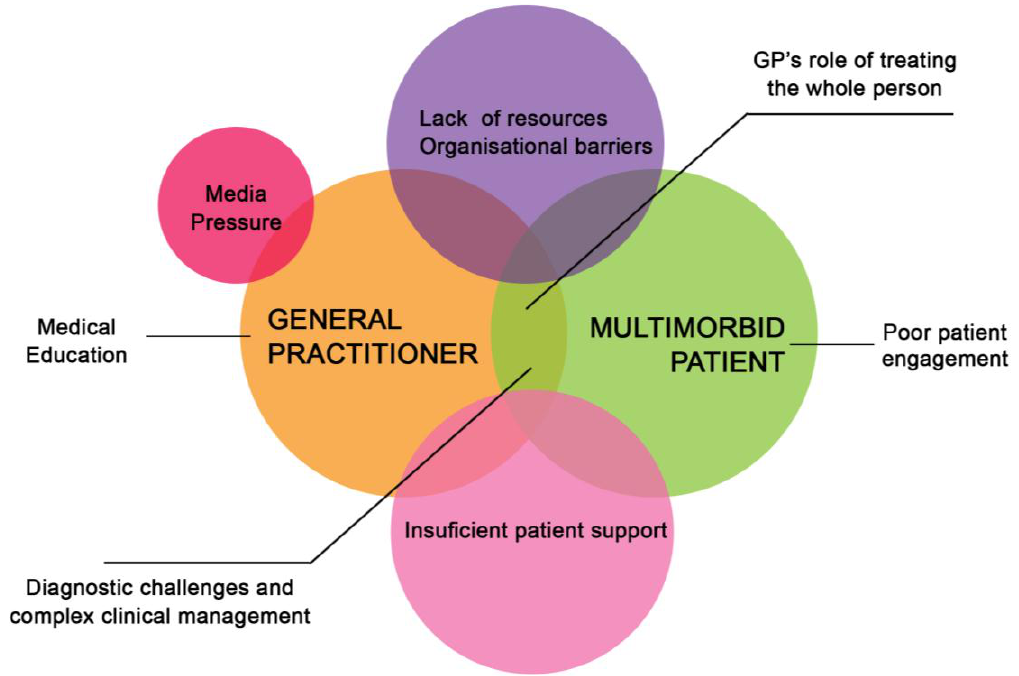
Figure 2. Relations between the perceived difficulties and challenges.